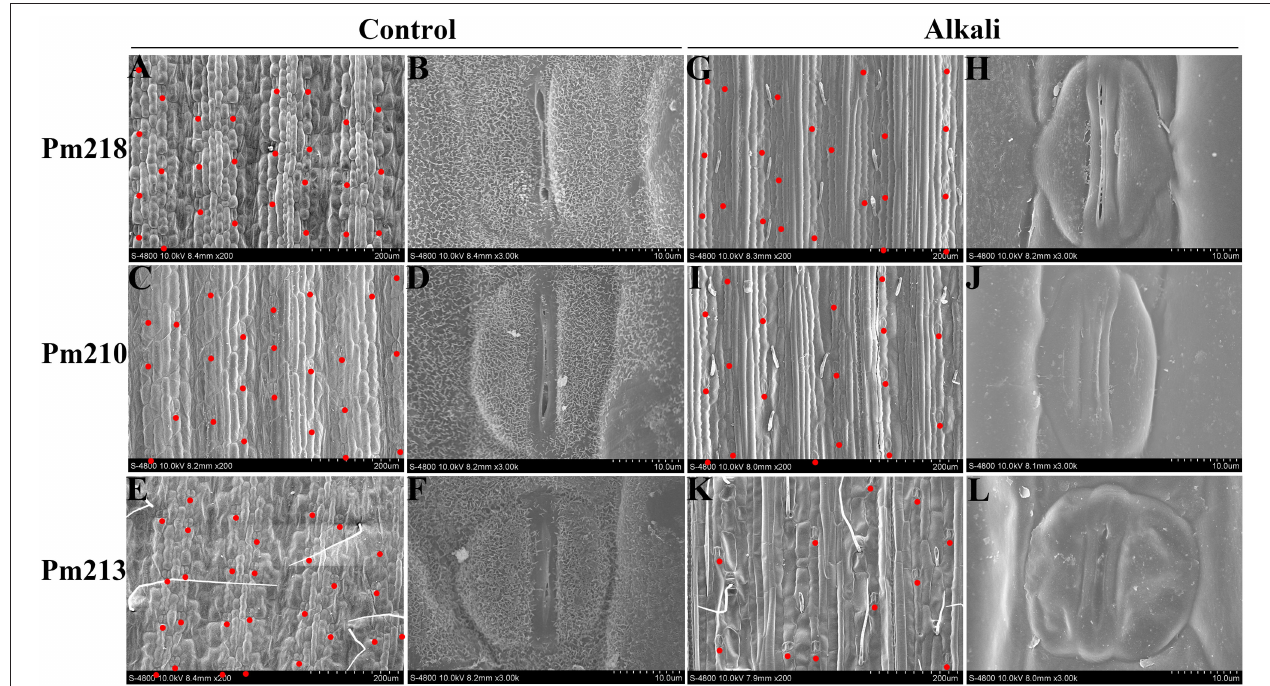
FIGURE 8 | The scanning electron microscope of the leaf surface { (A–F) : control condition [ (A,B) : Pm 218; (C,D) : Pm 210; (E,F) : Pm 213]} { (G–L) : alkali stress [ (G,H) : Pm 218; (I,J) : Pm 210; (K,L) : Pm 213]}. The red dot represents the location of the